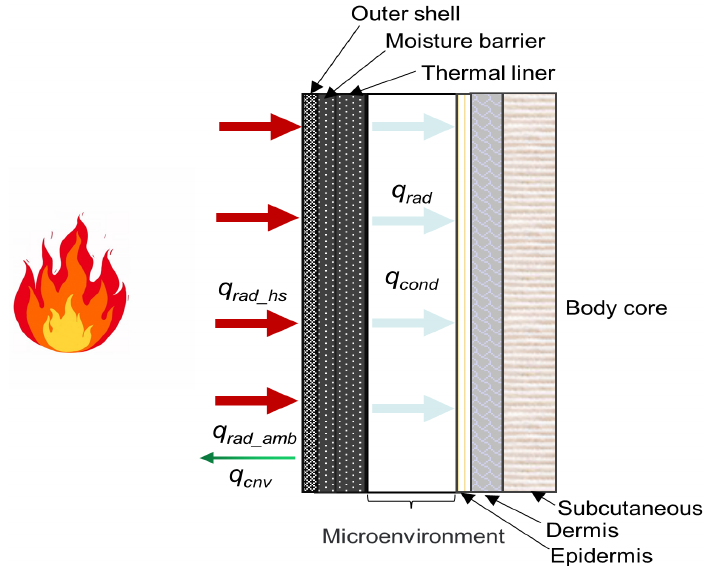
Figure 1. Schematic diagram of heat transfer mechanism in the skin–microenvironment–fabric system.